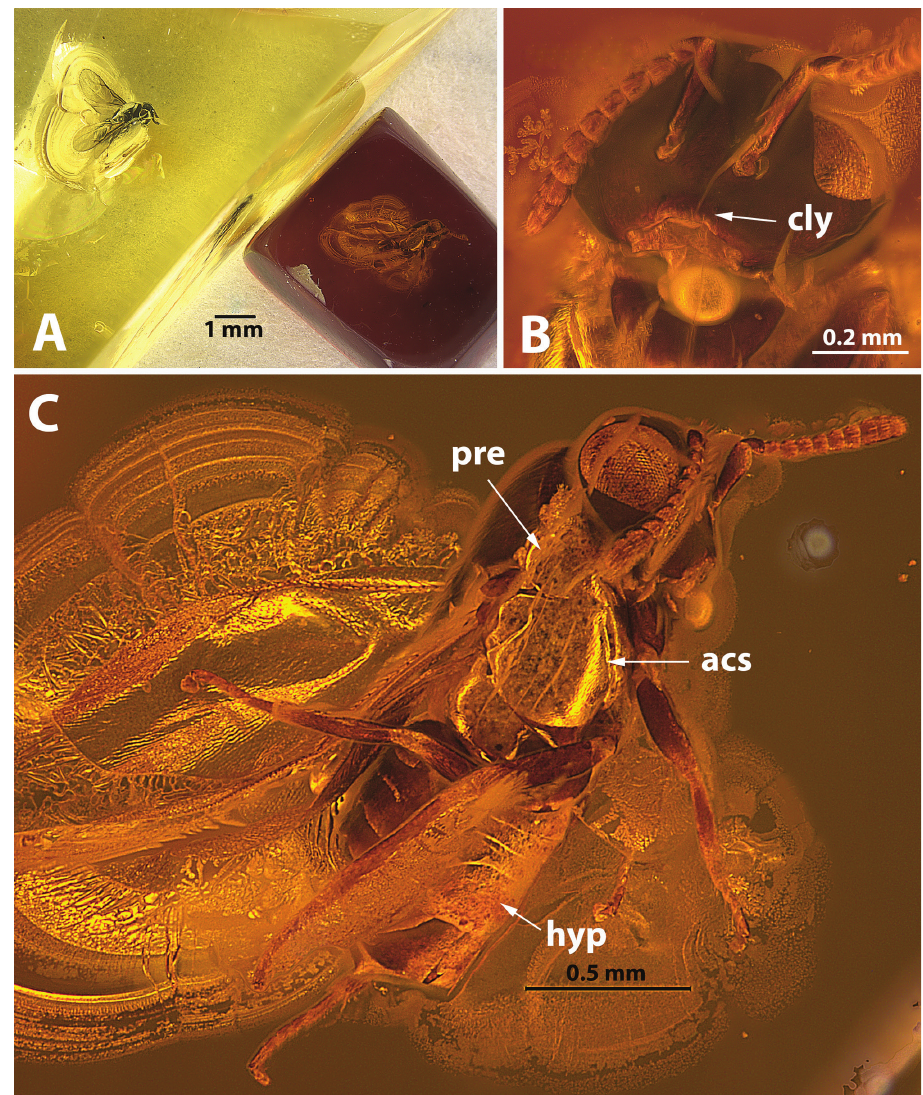
Figure 1. Sulia glaesaria , females A pieces of amber containing the inclusions: holotype in Danish amber, deposited in ZMUK (red) and new specimen from Rovno amber, deposited in SIZK (yellow) B head, holotype, ventrofrontal C habitus, holotype, right lateral (acs – acropleural sulcus, cly – clypeus; hyp – hypopygium, pre –